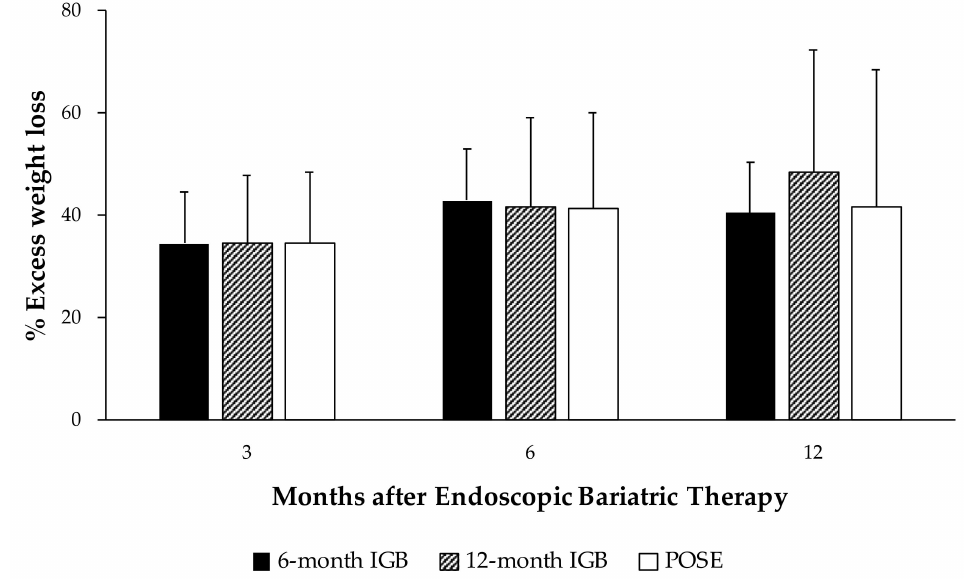
Figure 1. Comparison of excess weight loss between endoscopic bariatric therapies at 3, 6, and 12 months. IGB, Intragastric balloon; POSE, primary obesity surgery endoluminal. Values are expressed as mean and standard error measure. General linear models were used to compare the percentage of excess weight loss between good and poor weight-loss-responders. Analyses were adjusted for age, gender, initial BMI, and type of endoscopic bariatric